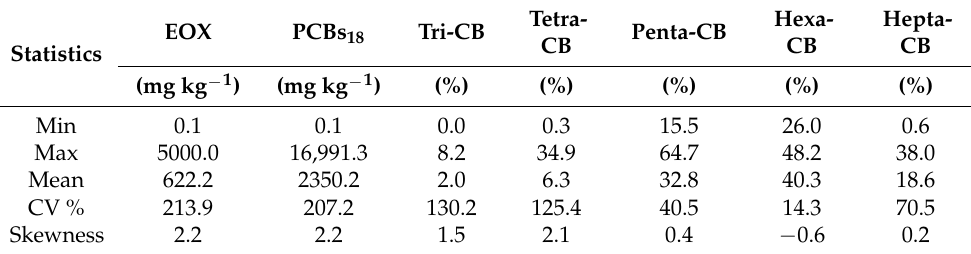
Table 2. Descriptive statistics of EOX and PCB contents in the soil samples.